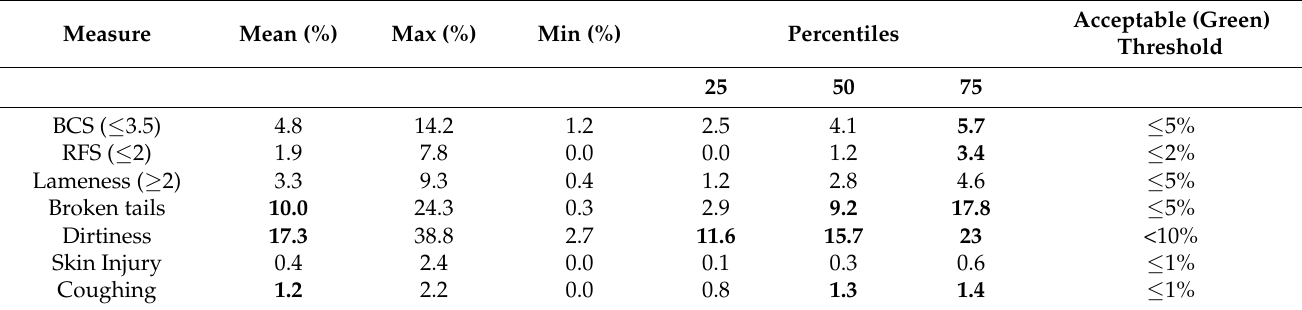
Figure 1. Heatmap representing welfare levels for eight animal-based measures from 23 dairy farms. All measures have three welfare levels (acceptable, green; marginal, orange; or unacceptable, red), except for the heads-up position which has only two levels (acceptable, green; and unacceptable, red). See Table 1 for further details of measurements and thresholds. Table 6. Descriptive statistics for selected animal-based measures from 23 farms and their compar- ison with a predetermined acceptable threshold (see Table 1 for details of measurements).